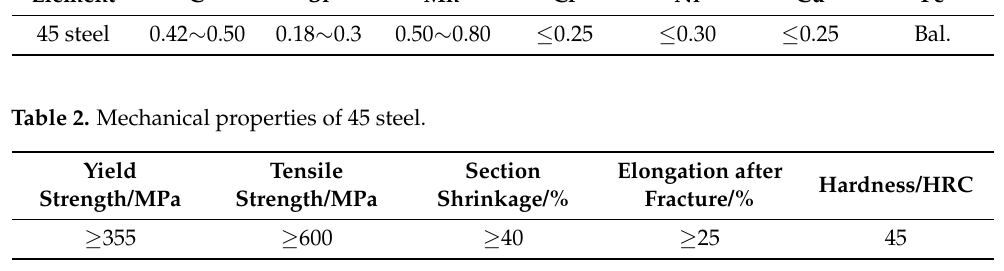
Table 3. Chemical composition of nickel tungsten carbide powder Ni60 + 15 WC (mass fraction, %).